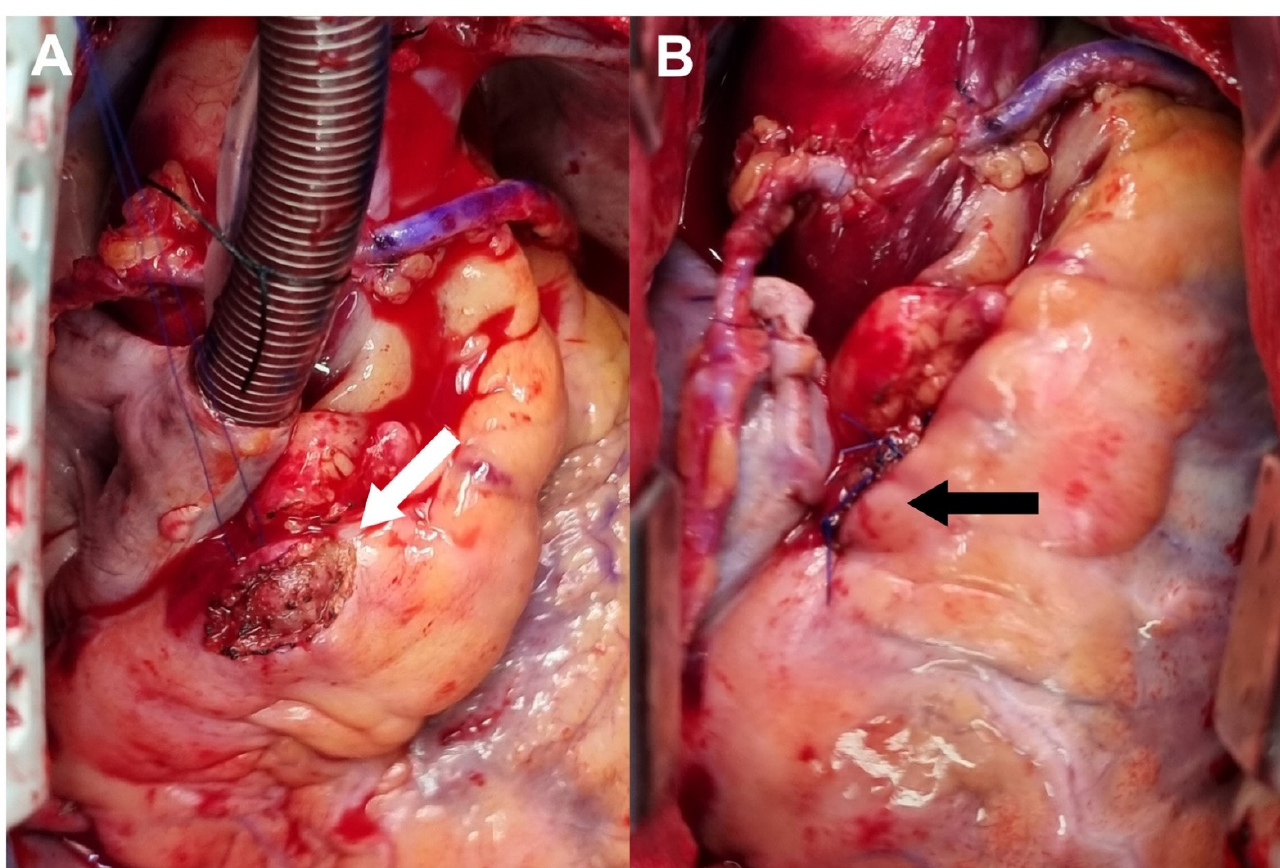
Figure 1. Operative Findings. ( A ) The right coronary artery was exposed at its proximal portion (white arrow). ( B ) Suture ligation was performed at the proximal and distal portions of the right coronary artery aneurysm (black arrow).